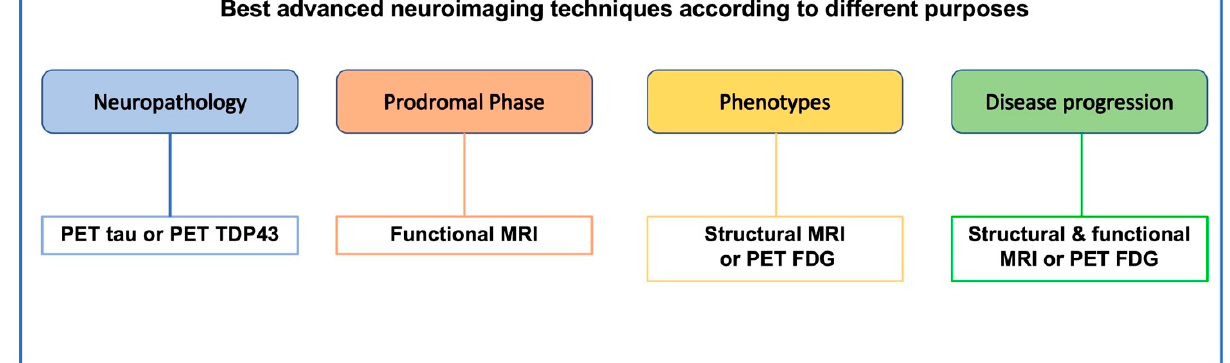
Figure 1. Proposed advanced neuroimaging techniques according to different aims. Advanced neuroimaging allows to investigate different aspects of FTD, from defining neuropathology to early and differential diagnosis and disease progression. Different techniques are suitable for each of these aims.